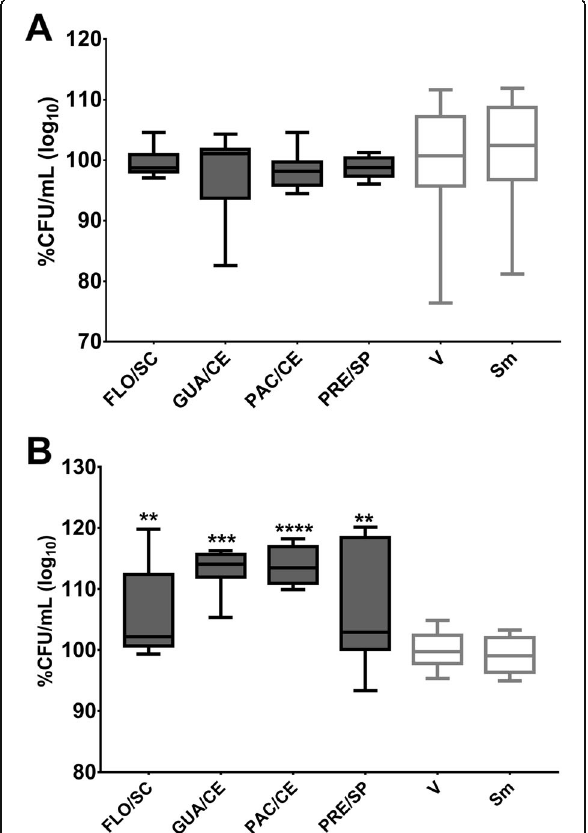
Fig. 6 S. mutans detachment after adhesion to the treated salivary pellicle and initial matrix of glucans. Post-release data of S. mutans to the treated salivary pellicle and glucans are shown in ( a ) and ( b ), respectively. There was no difference between the control vehicle (V), and the extracts tested for both analyses. The percentage of CFU/mL was obtained considering the vehicle control (V) as 100%. The data described are median (traces) and interquartis (boxes). The error bars represent the maximum and minimum values. The asterisks denote a statistically significant difference of a specific extract versus vehicle control (V), where **** p = 0.0001 and ** p < 0.0031 (Kruskal-Wallis test, followed by the multiple comparison test of Dunn). The growth control is represented by Sm for S. mutans. The colors of the bars of the graph represent the variety to which the extracts belong, being the color dark gray to var.